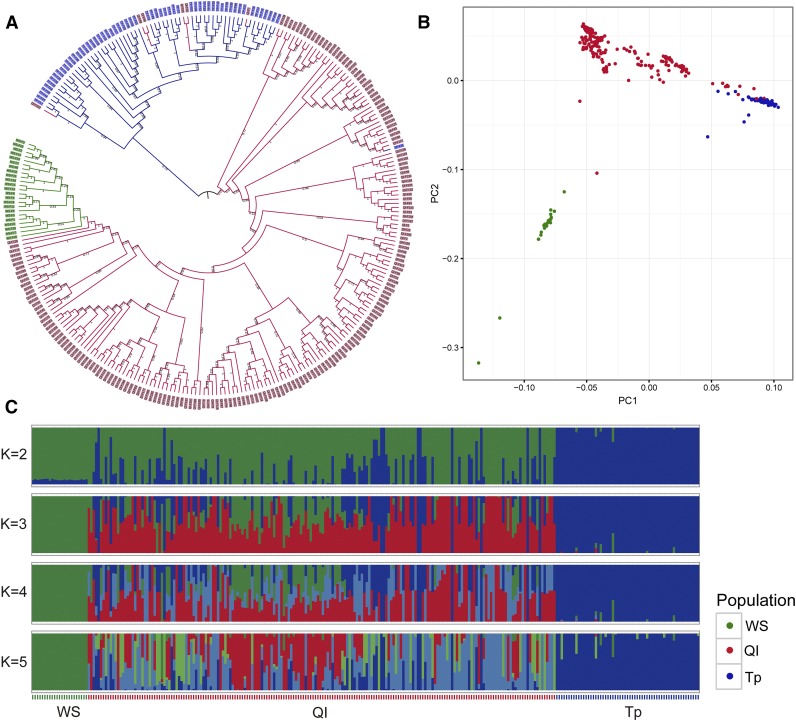
Phylogenetic relationships and population genetic structure. (A) A neighbor-joining tree for the forest musk deer constructed by PHYLIP (version 3.69) based on the high-quality SNPs. The numbers in the figure represent bootstrap values. (B) Principal component analysis (PCA) of forest musk deer was implemented in GCTA. The plot was based on the first two principal components. (C) Population genetic structure was inferred by Admixture (version 1.3.0). The number of populations (K) was pre-defined from 2 to 5 and each color represents one putative ancestry background. The Y axis quantifies group membership and the X axis shows different individuals.